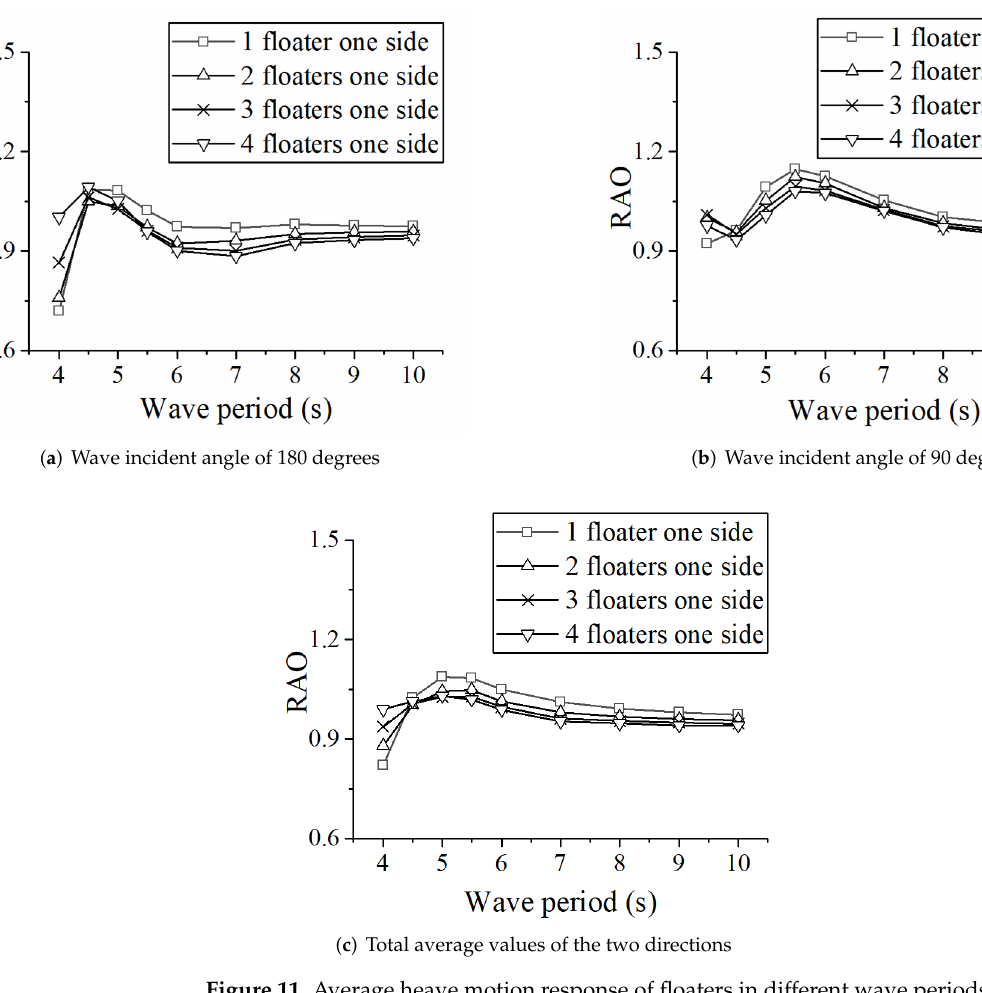
Figure 11. Average heave motion response of floaters in different wave